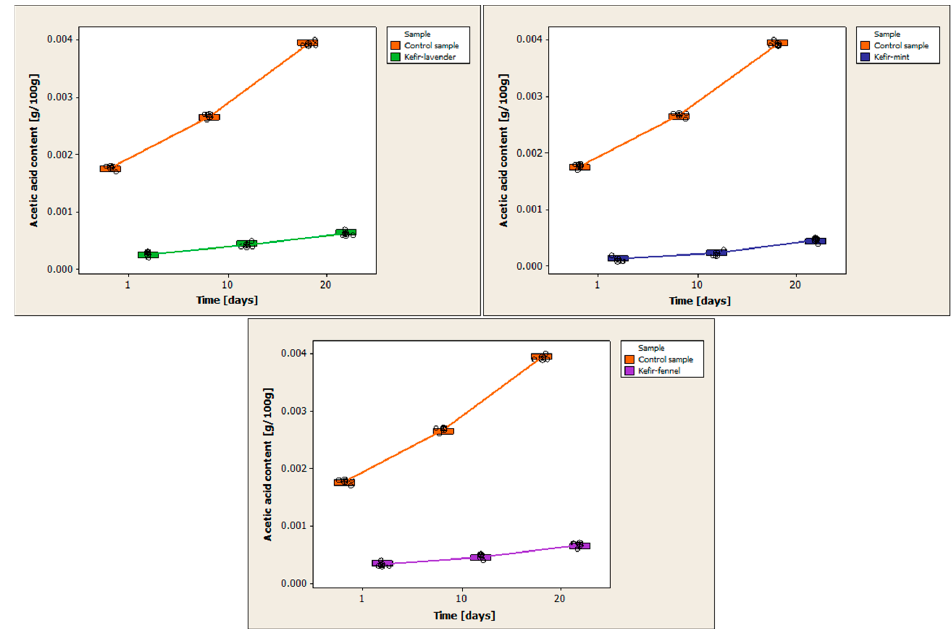
Figure 7. Comparative variation of acetic acid content determined by the enzymatic method in kefir samples with encapsulated volatile oils and the control sample.